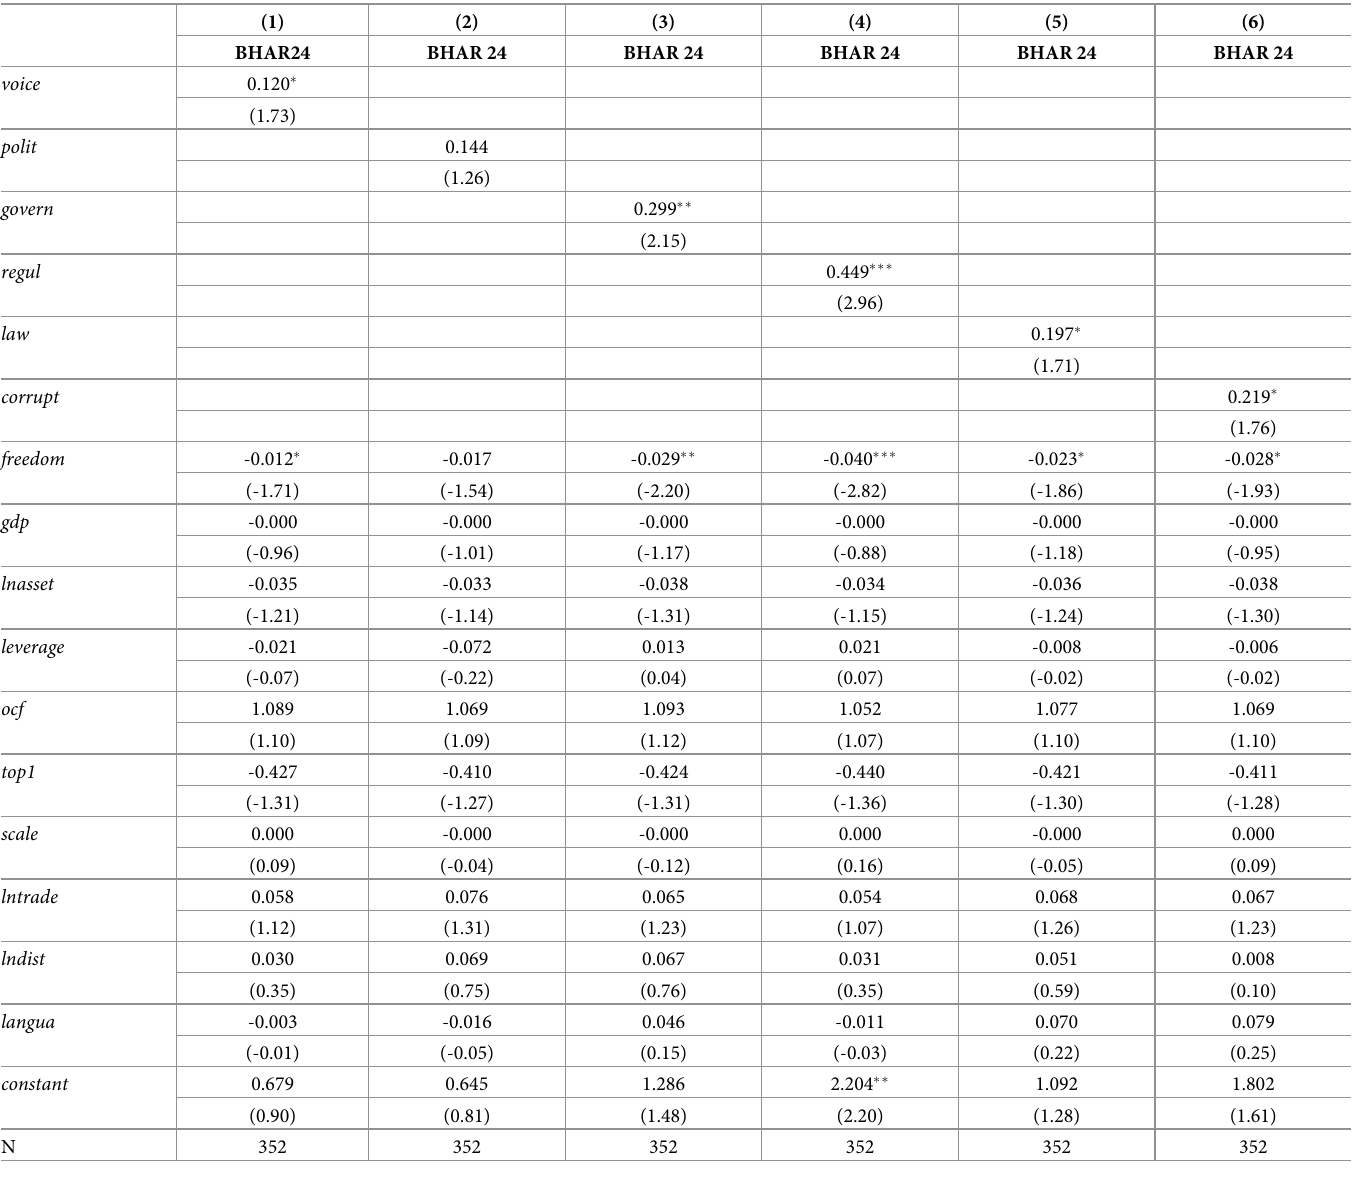
Table 3. Six dimensions of governmental governance capacity and